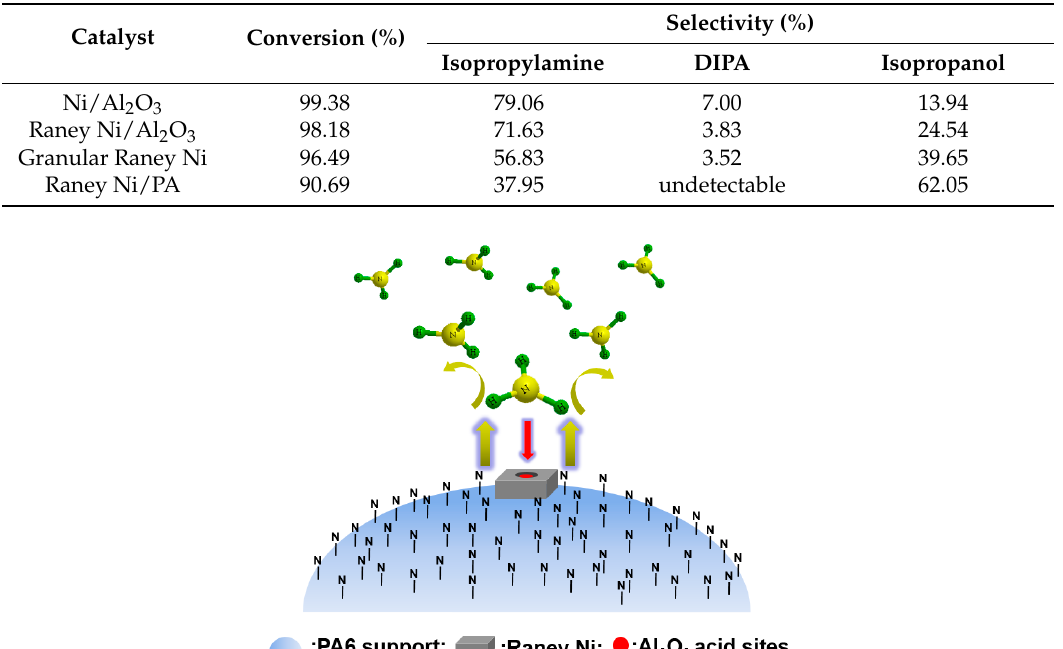
Table 4. Hydroamination of acetone with different catalysts over 153°C. Reproduced from [18] with permission from Jiang H., Sci. China Chem.; published by Springer, 2016.